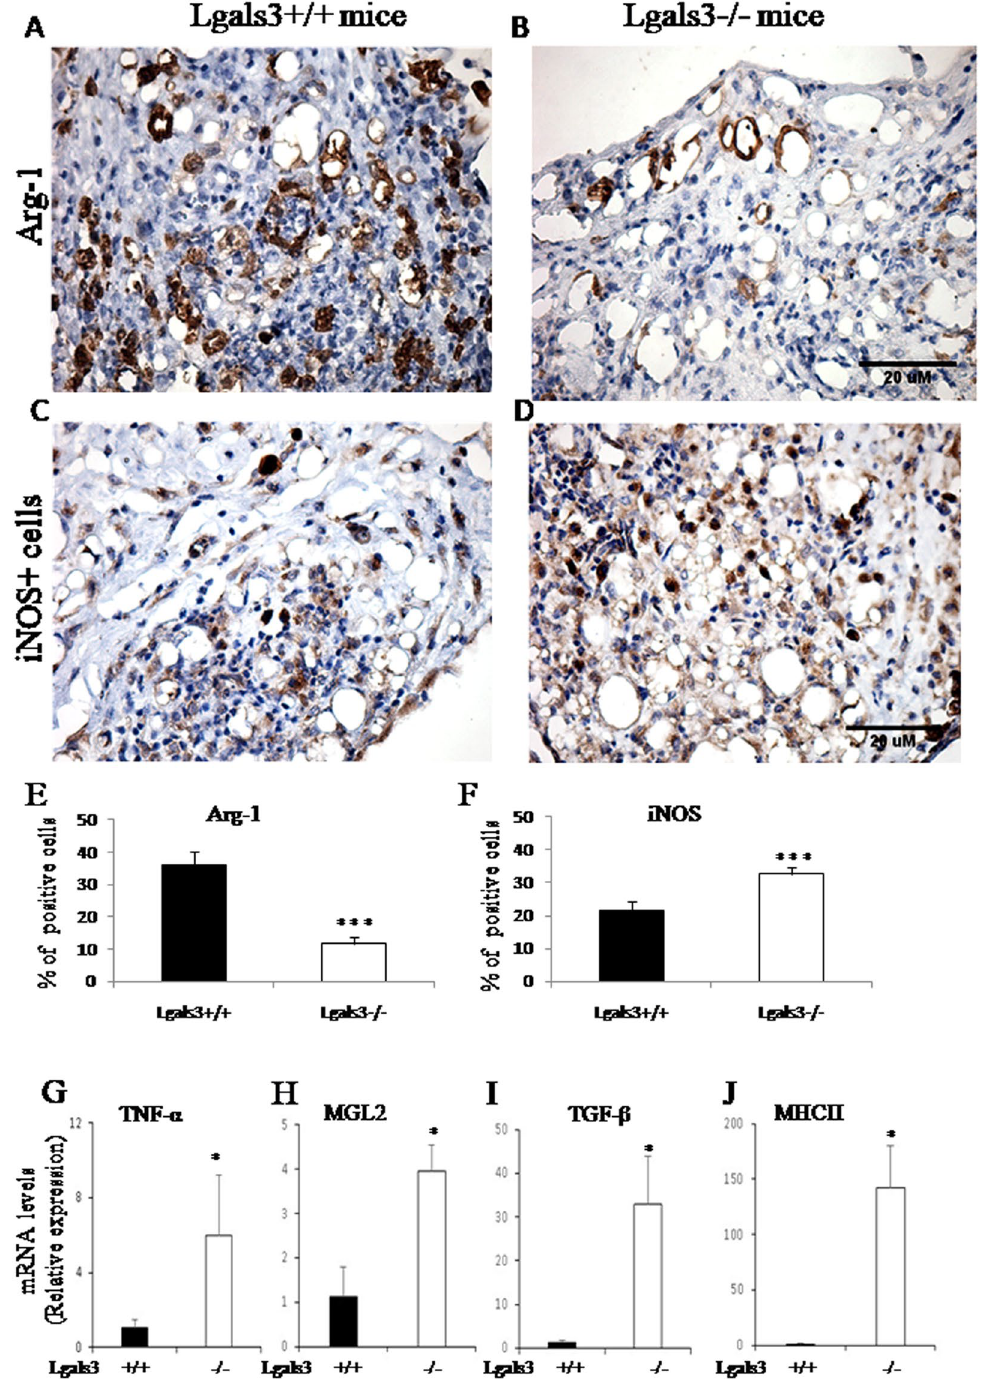
Figure 3. Analysis of M1/M2 markers on pristane-induced mice. Arginase-1 (M2 marker) was evaluated in mesenteric cells of pristane-induced Lgals3 + / + mice (A) and Lgals3 − / − mice ( B ). Arrows pointed to crown-like structures positive to Arg-1 in both mice groups. ( C and D ) iNOS (M1 marker) was detected in pristane- induced Lgals3 + / + and Lgals3 + / + mice, respectively. Bar graphs indicate the percentage of Arg-1 + cells ( E ) and iNOS + cells ( F ). By real-time PCR, the expression of M1 genes (TNF- α and MGL-2) and M2 genes (TGF β 1 and MHCII) was monitored and relative expression was plotted in graphs (G-J, respectively). Black bars represent Lgals3 + / + mice whereas white bars represent Lgals3 − / − mice. Data are representative of three independent experiments. Magnification: A-D (200 × ). ( * ) indicates p < 0.05. ( *** ) indicates p <